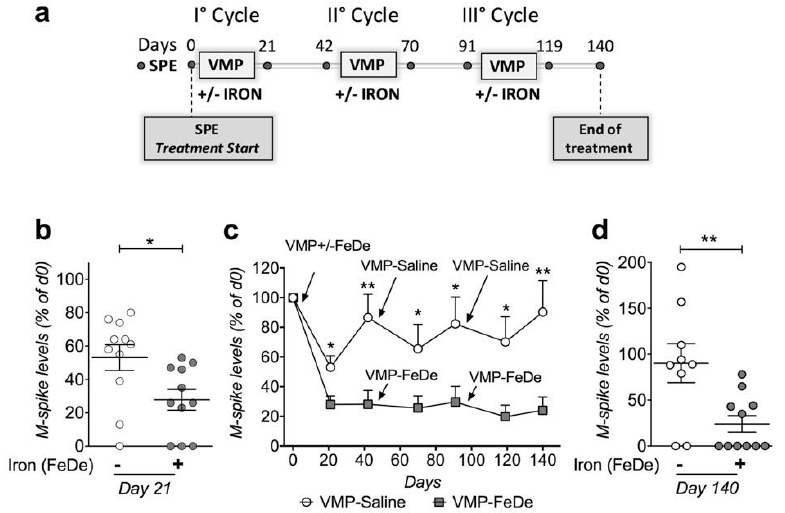
Figure 5. Iron improves bortezomib-melphalan-prednisone (VMP) regimen efficacy in Vk*MYC mice . ( a ) Treatment schedule. Mice were treated with VMP regimen plus/minus 100 mg/Kg iron dextran (FeDe) for 3 consecutive cycles administered at 7 weeks intervals. Disease expansion was determined by measuring serum monoclonal component (M-spike) by serum protein electrophoresis (SPE) at indicated time points. ( b ) Variation of M-spike levels from treatment start (Day 0) in VMP-Saline (n.11) and VMP-FeDe (n.11) treated mice at day 21 of the first cycle. Each circle in the scatter graph indicates M-spike reduction of each mouse analyzed. ( c ) Variation of M-spike levels from treatment start at indicated time points during follow-up. Data are shown as means +/- standard errors of M-spike variation in the 2 treatment groups. ( d ) M-spike variation at the end of treatment (day 140). Each circle in the scatter graph indicates M-spike reduction of each mouse analyzed. Two VMP-Saline mice died during the experiment. Statistically significant differences between VMP-FeDe and VMP-Saline mice were determined by t-test. * p < 0.05; ** p < 0.01.